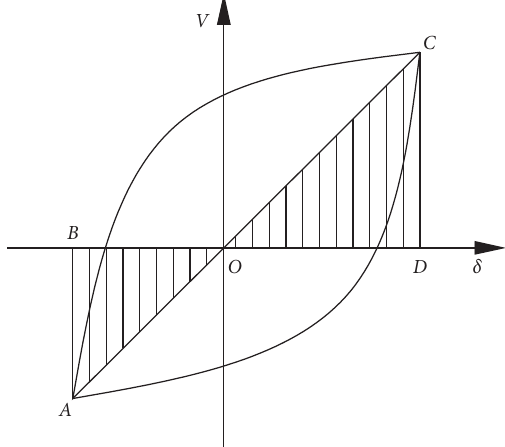
Figure 12: Load-displacement hysteresis loop of the pseudostatic